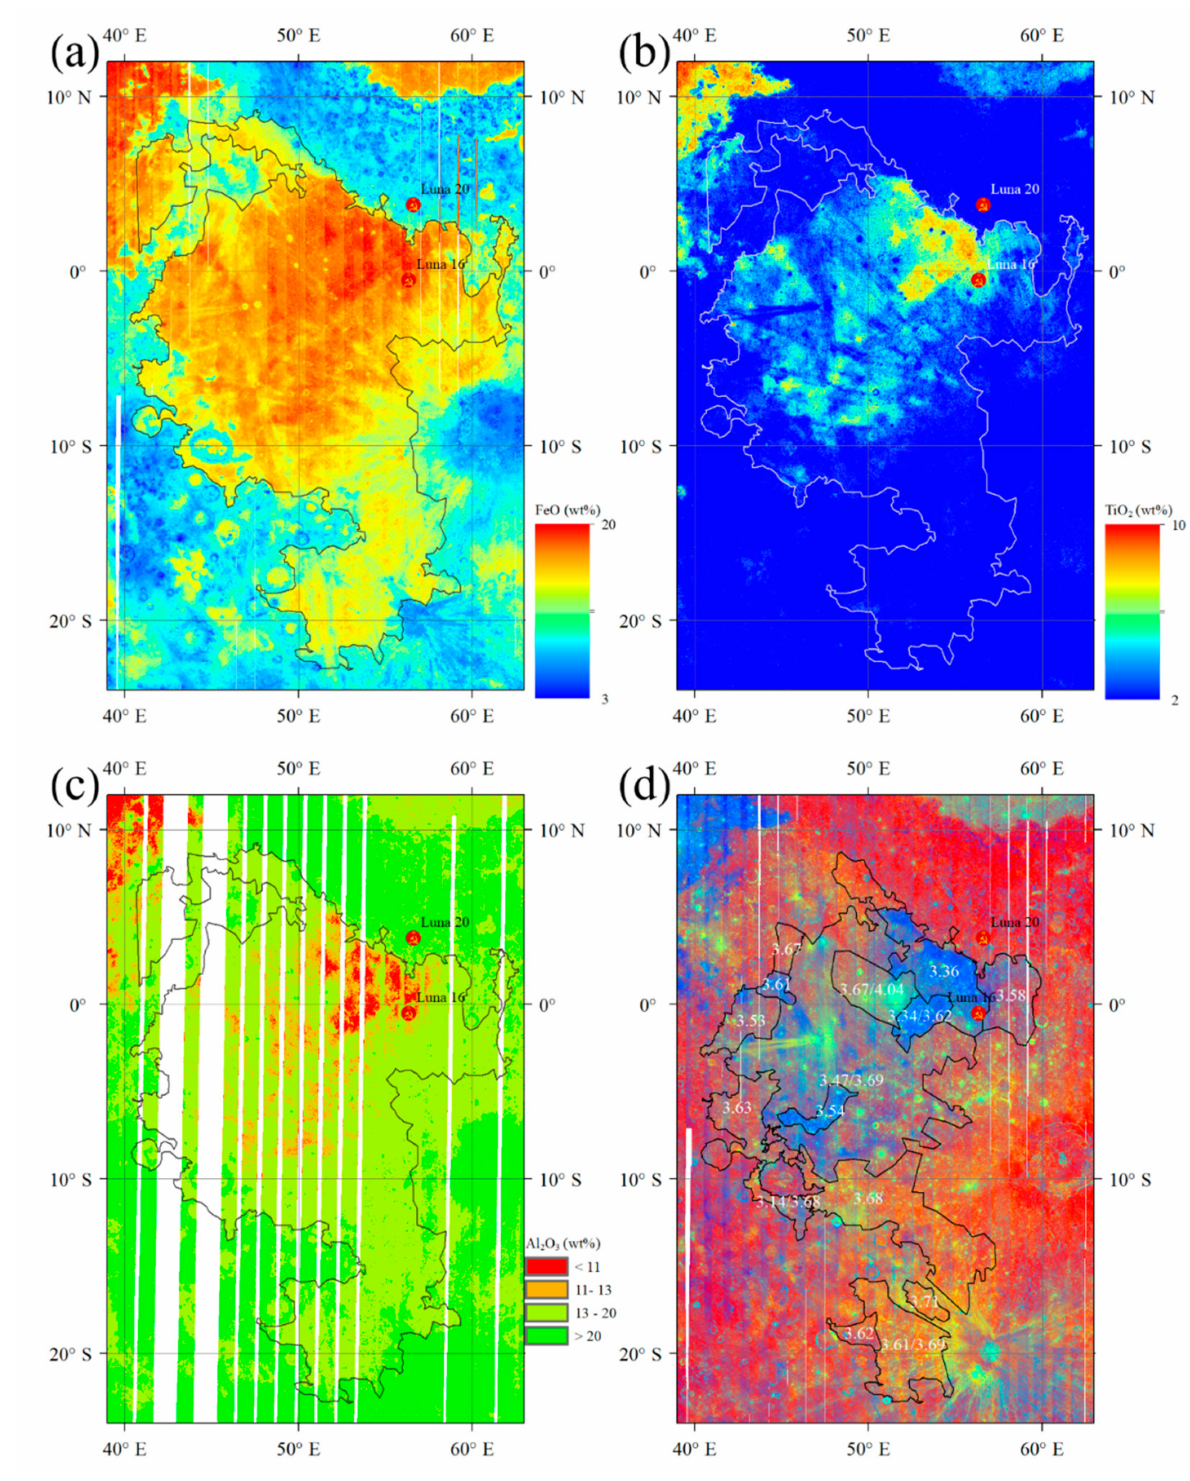
Figure 4. The ( a ) MI FeO map, ( b ) WAC TiO 2 map, ( c ) IIM Al 2 O 3 map, and ( d ) MI color ratio map and the age of different geological units (adapted from [12]) of Mare